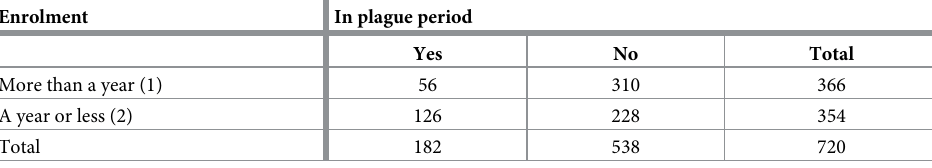
Table 2. Plague data for the Black Death